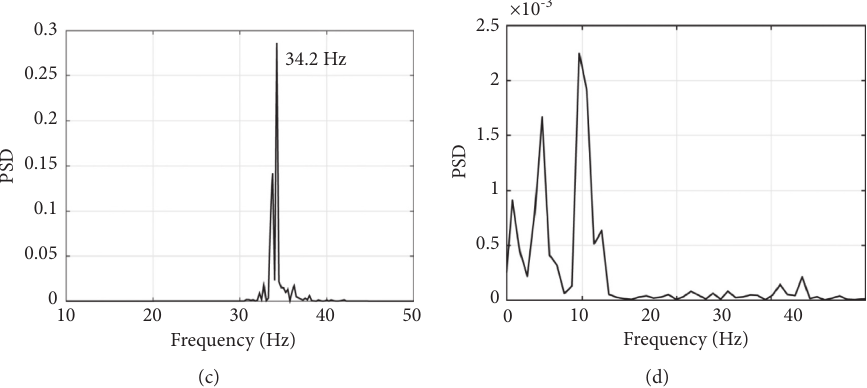
Figure 18: Comparison of lift coefficient and PSD with and without spoilers for Example 2. (a) Time history of lift coefficient (bare). (b) Time history of lift coefficient (with spoilers). (c) PSD of the lift coefficient (bare). (d) PSD of the lift coefficient (with